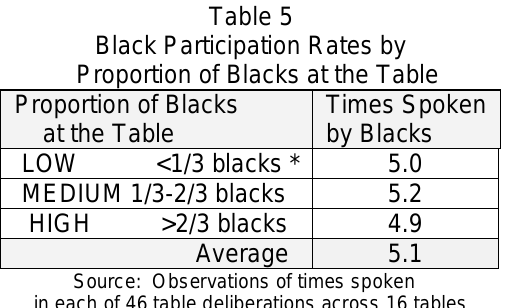
Times Spoken by Blacks